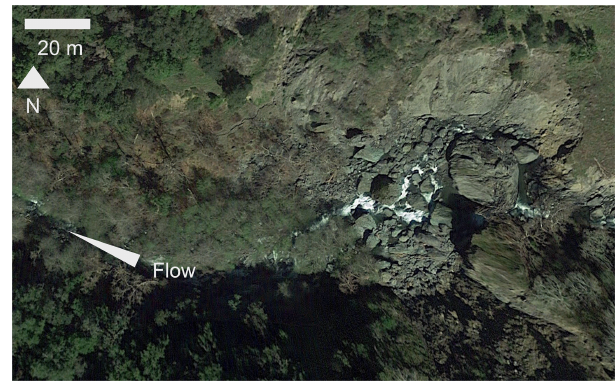
Figure 11. Normalized histogram of annual earthflow displace- ments in the Franciscan mélange; data are from Kelsey (1978) and Nereson and Finnegan (2019). Black line shows exponential fit between normalized frequency and displacement. Vertical dashed lines indicate the channel width of Arroyo Hondo and the Eel River.